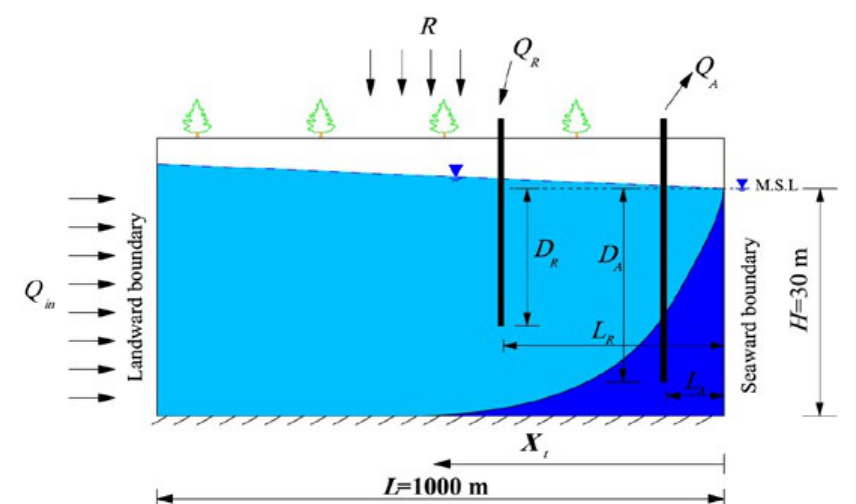
Fig. 1: The geometry and boundary conditions of hypothetical aquifer model